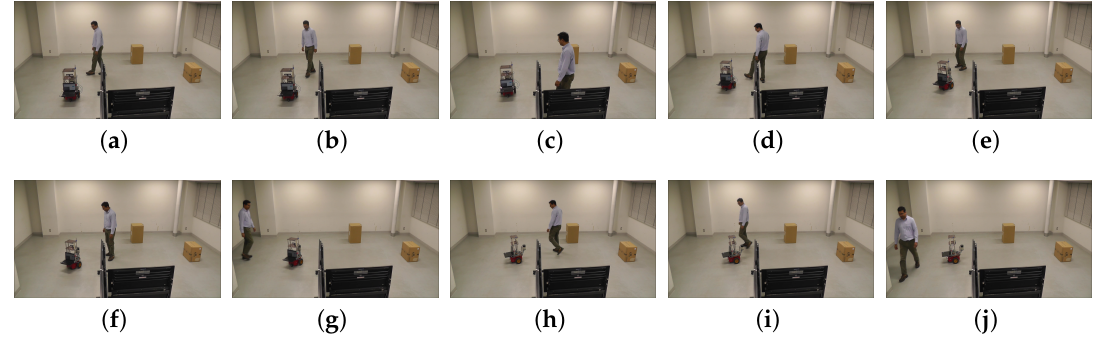
Figure 16. Dynamic obstacle experiment with P3DX navigation from position S to G in Figure 9. ( a – j ) Person moved randomly in front of P3DX for a long time moving in and out of the range of sensors. P3DX changed trajectories or stopped if the obstacle was dangerously close. ( Supplementary Materials )